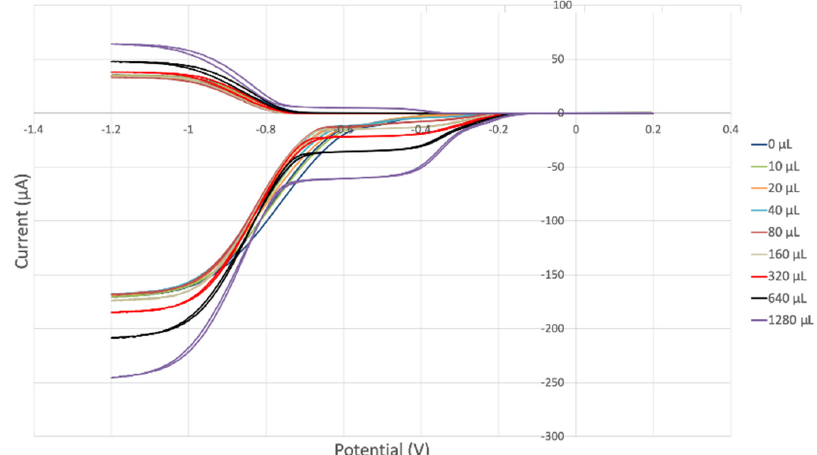
Figure 7. TQ RRDE cyclovoltammetry.